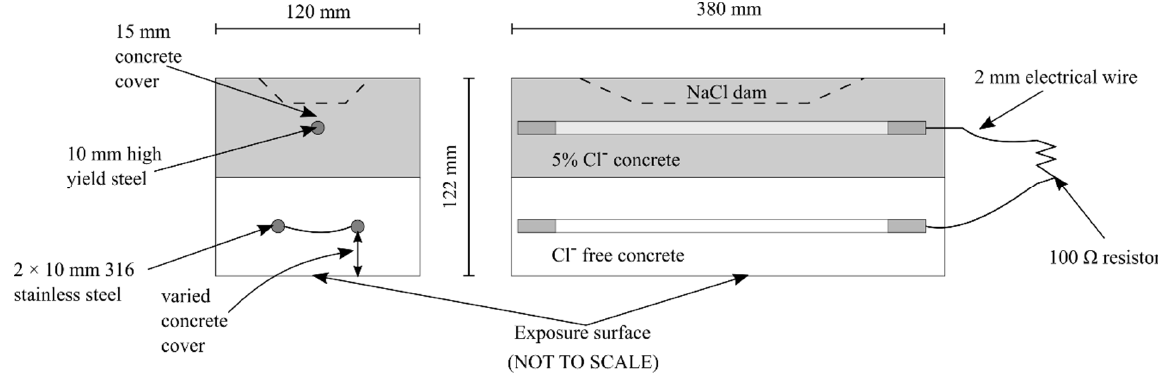
Figure 5. Schematic of macrocell corrosion prism.